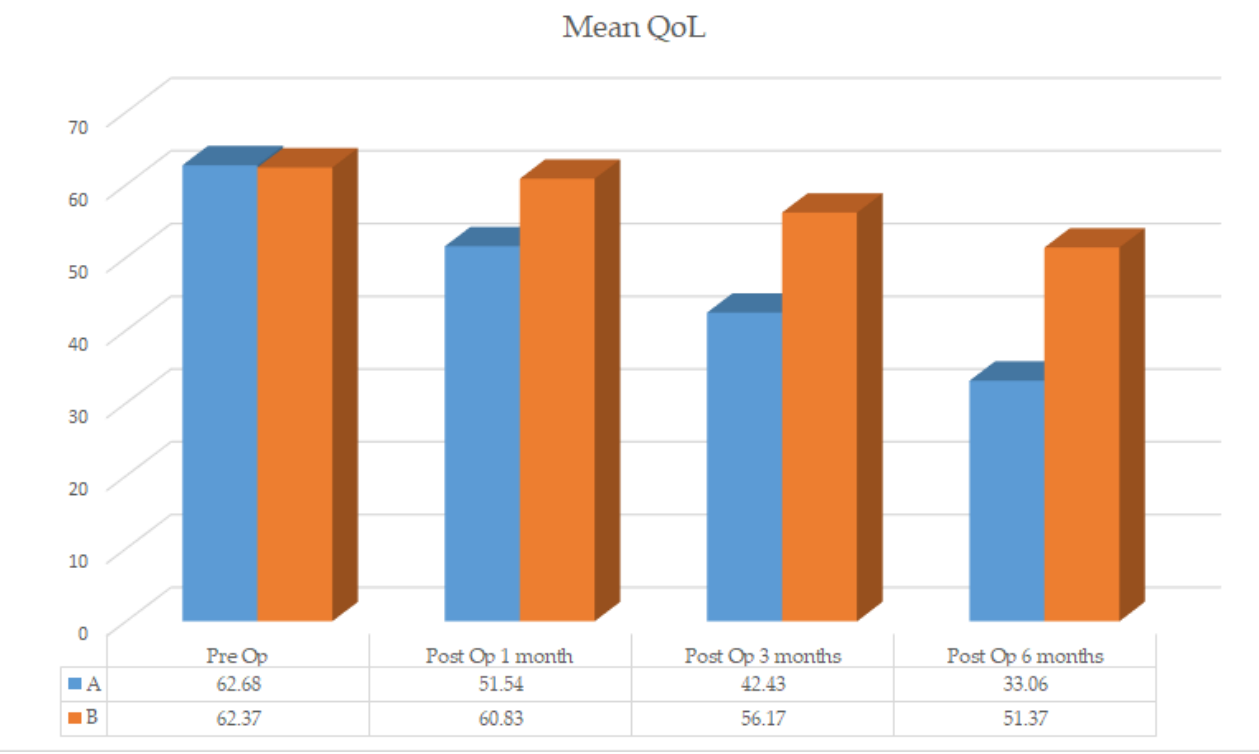
Figure 8. Global quality of life group A vs. group B.